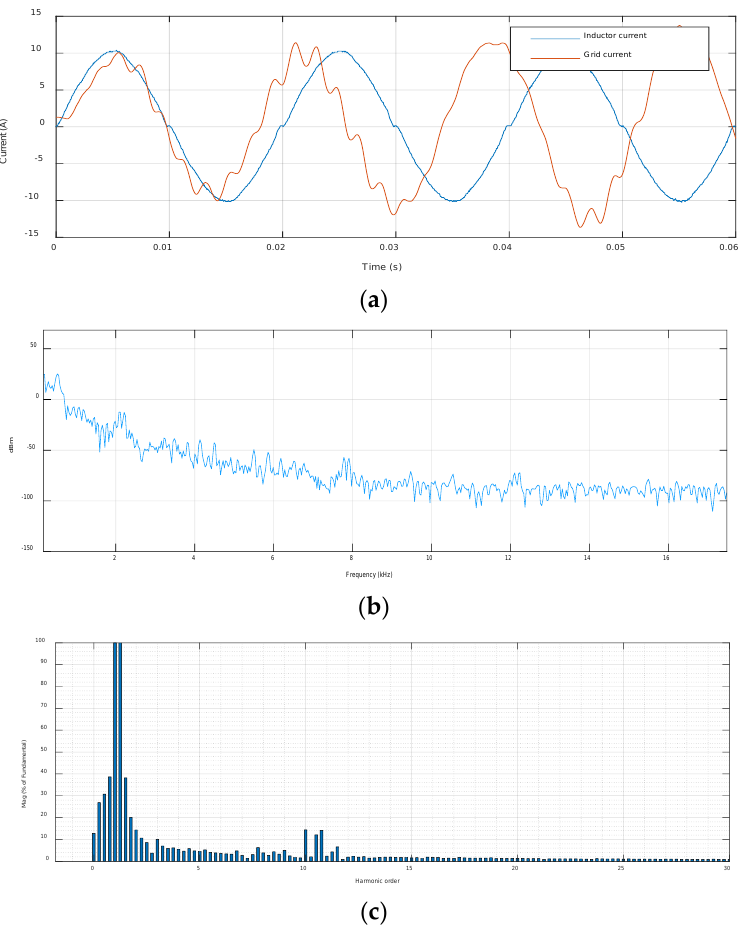
Figure 12. System response without control: ( a ) I grid vs. I L with THD_ I grid = 20.38%, ( b ) spectrum analysis of I grid , ( c ) Harmonics contents of I grid.